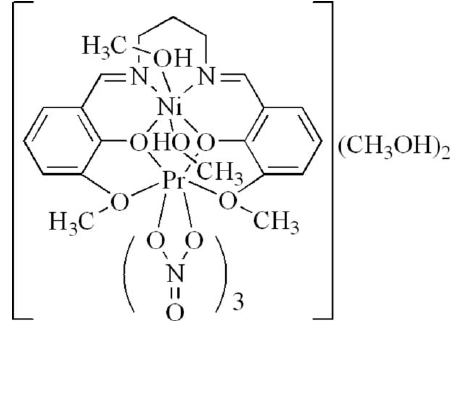
used to prepare material for publication: SHELXL97